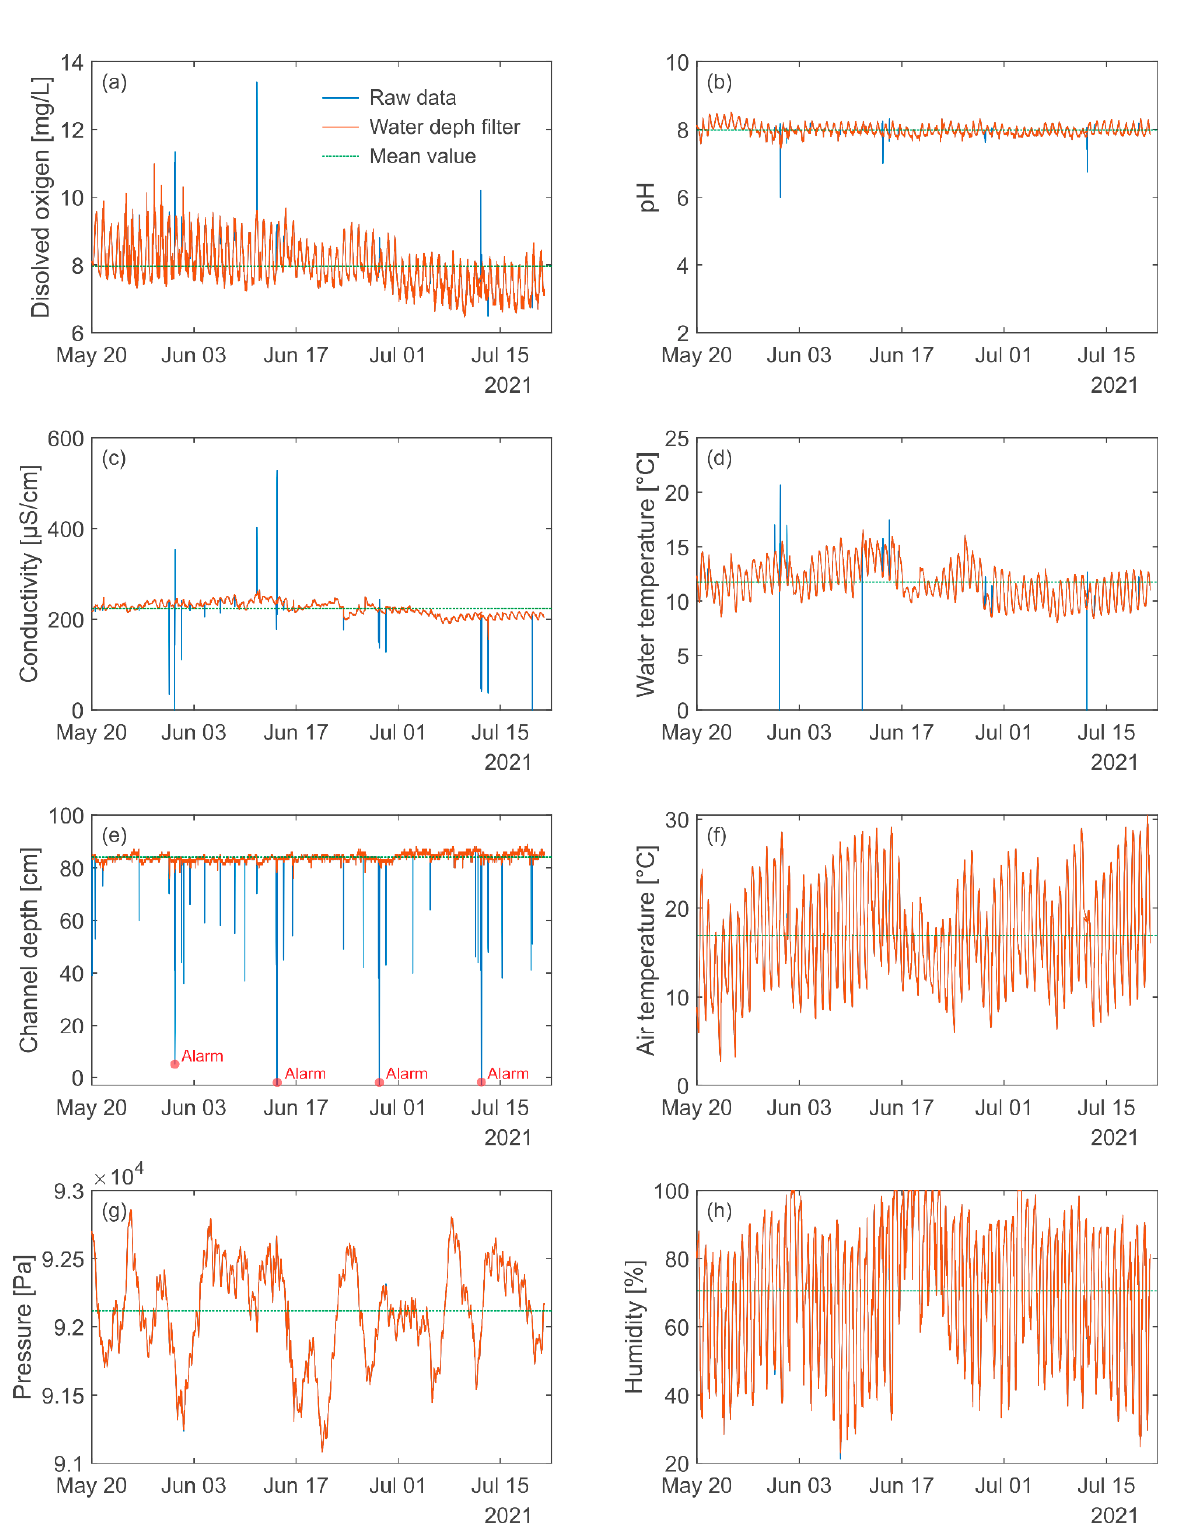
Figure 8. Data collected by MS Quality and exported to the web server by the network. In blue raw data and in red after minimum depth filtering to ensure the sumergence of water quality sensors (depth > 75 cm): ( a ) Disolved oxigen (mean = 7.96 mg/L); ( b ) pH (mean = 7.98); ( c ) Conductivity (mean = 223.64 μ S/cm); ( d ) Water temperature (mean = 11.76 °C); ( e ) Channel depth (mean = 84 cm); ( f ) Air Temperature (mean = 16.90 °C); ( g ) Barometric pressure (mean = 92118 Pa); ( h ) Humidity (mean = 70.53%).